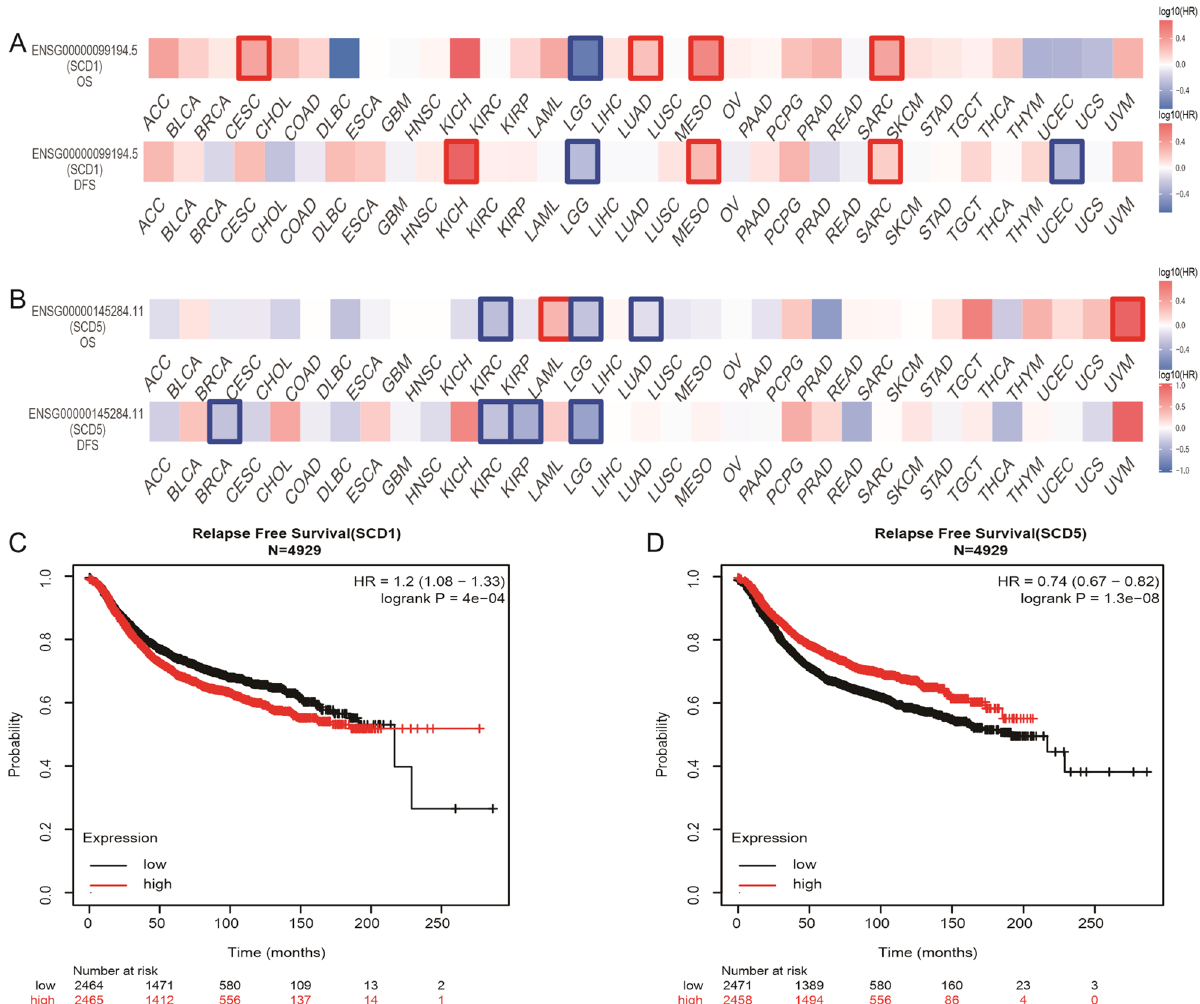
Figure 4. The prognostic significance of SCD1 and SCD5 in human cancers. ( A , B ) Survival map of SCD1 and SCD5 in human cancers by using samples from TCGA. ( C , D ) Survival analysis of SCD1 and SCD5 expression in breast cancer by using Kaplan Meier